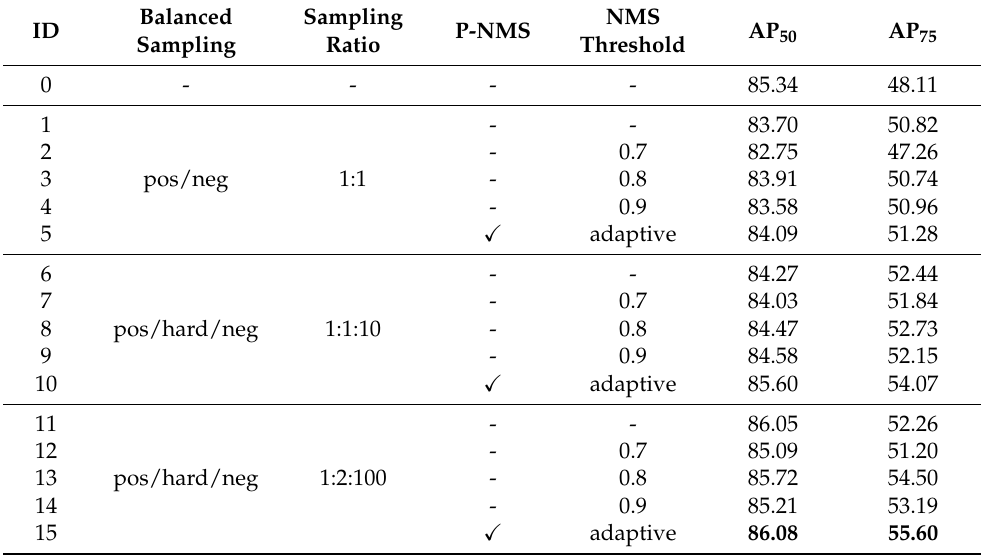
Table 2. Analysis of sparse label assignment on HRSC2016 dataset.